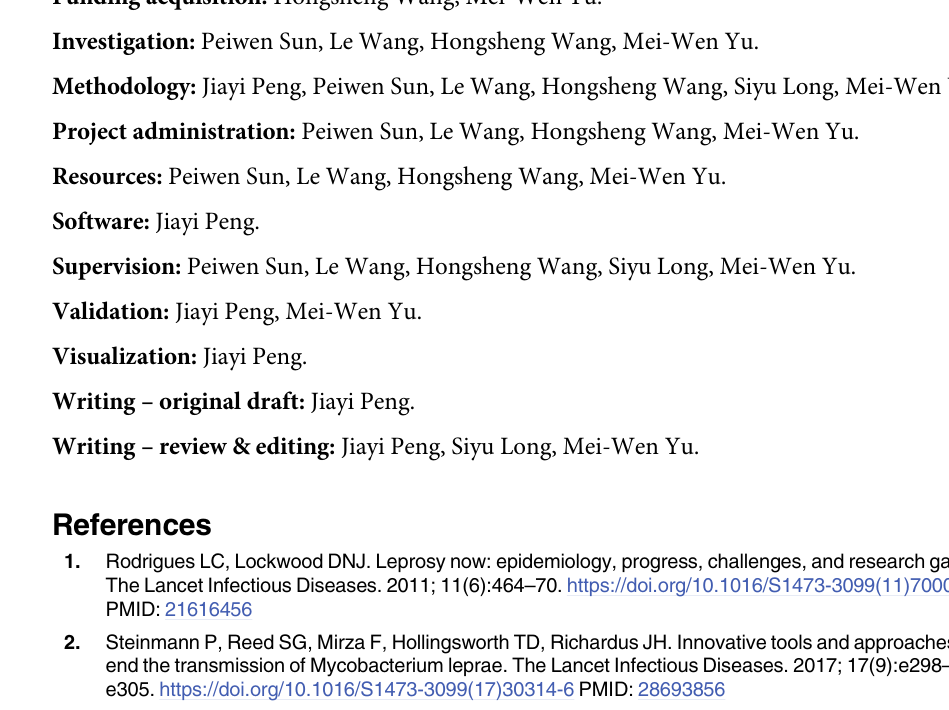
S3 Table. Diagnostic delay period of pediatric new leprosy cases by endemic areas